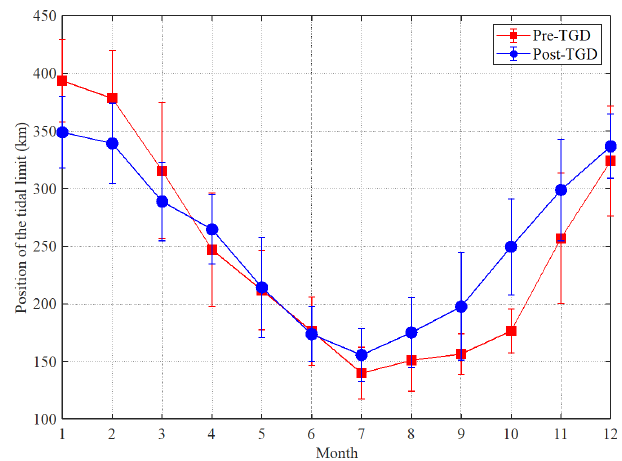
Figure 11. Temporal variation of the position of the tidal limit rela- tive to the TSG station for both the pre-TGD and post-TGD periods. The vertical error bar at each data point indicates the standard devi- ation of the analytically computed time